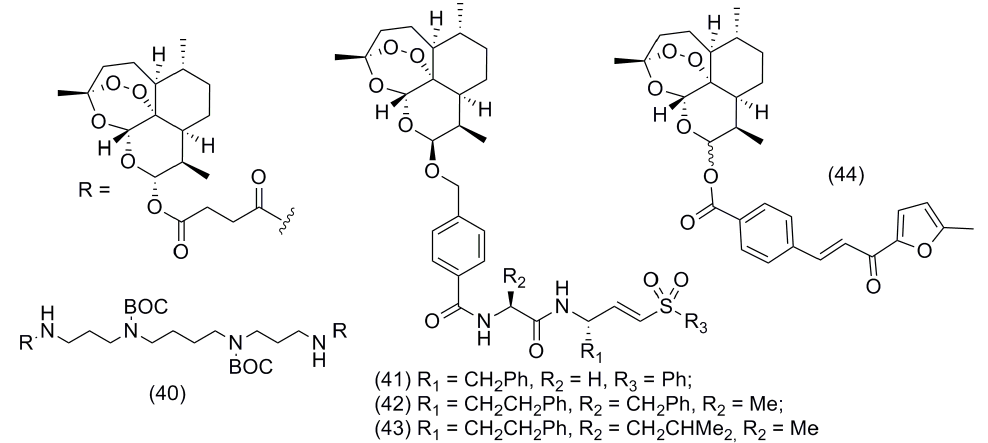
Figure 15 - Structures of ART derivatives 40-44